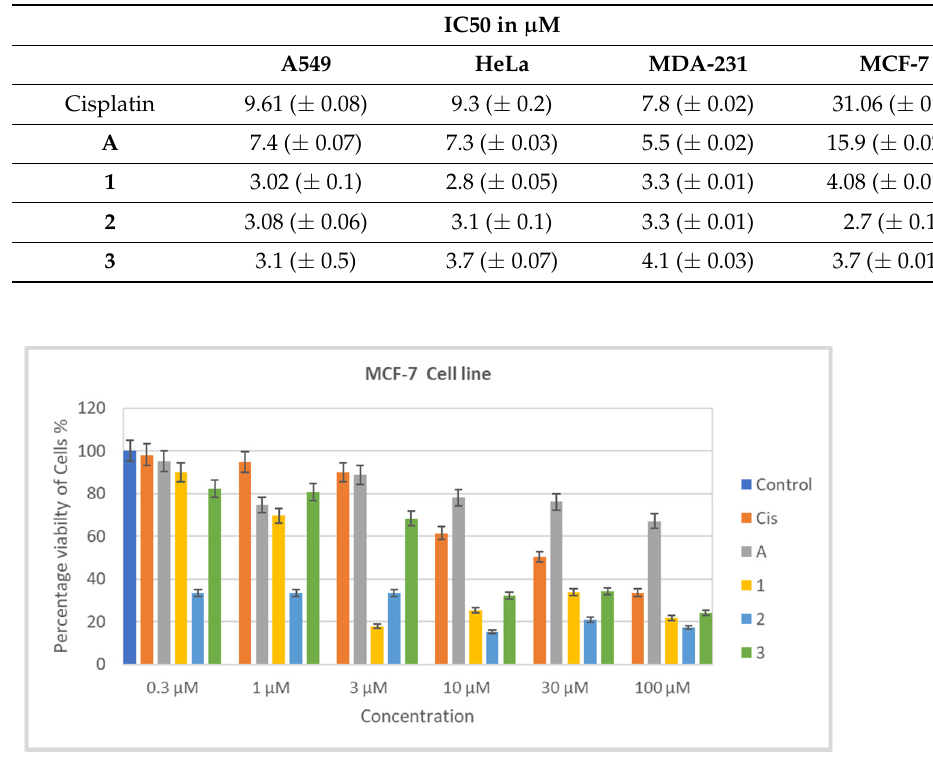
Figure 1. Effect of the concentration of complexes A, 1 – 3 and cisplatin on the viability of MCF-7 cells.